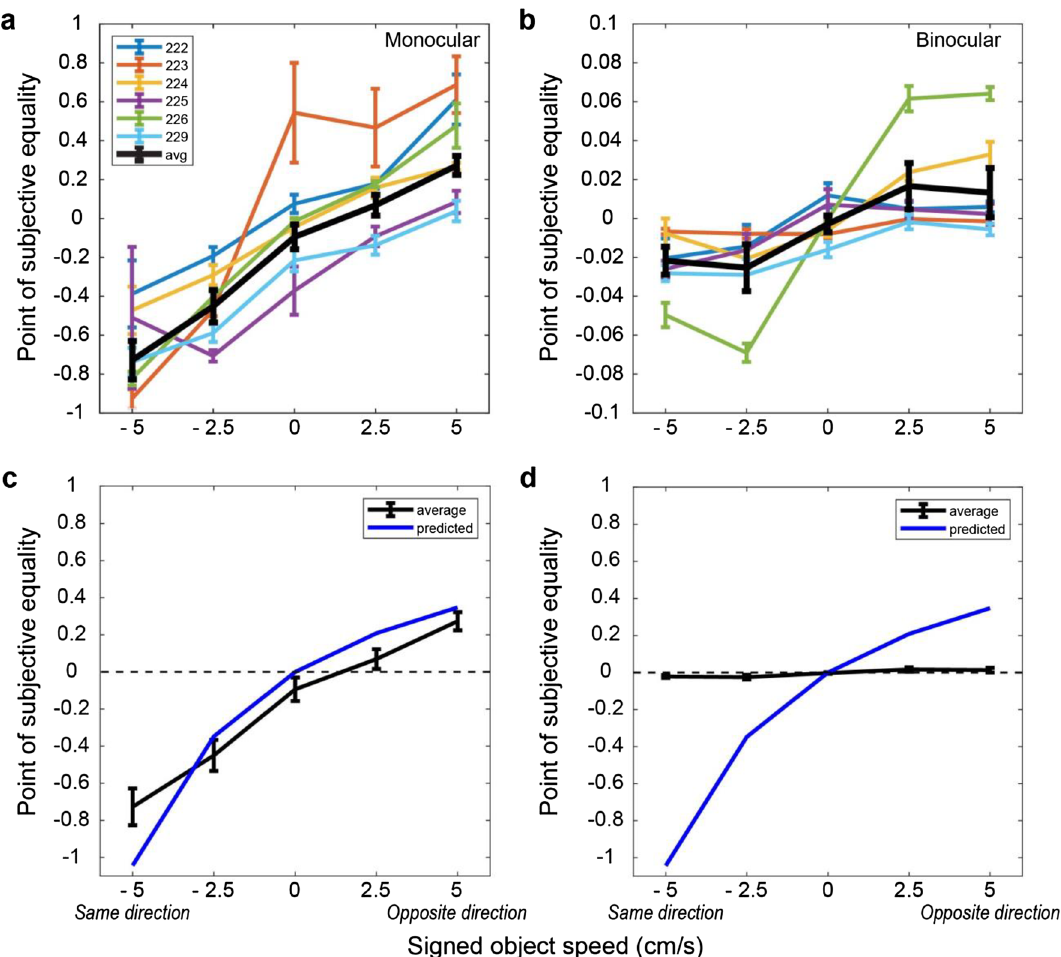
Figure 6. Summary of depth biases across subjects. ( a ) PSE values for the monocular condition are plotted as a function of SOS for each individual subject (colored lines), along with the group average (black). ( b ) PSE values are shown for the binocular condition; format as in panel ( a ). ( c ) The group average data from the monocular condition (black) is compared with the predicted PSE values (blue) under the assumption that subjects estimate depth from the net retinal velocity of the object. ( d ) Comparison between group average and predicted PSE values for the binocular condition; format as in panel ( c ). Error bars for individual subjects represent SEM across blocks of trials; error bars for group averages represent SEM across